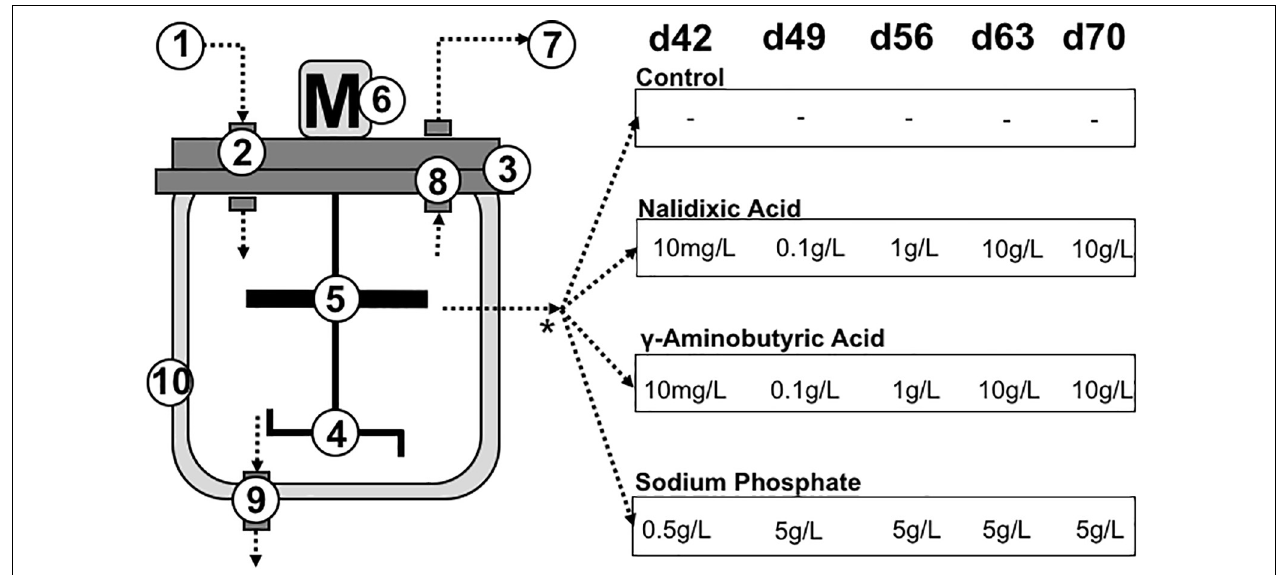
FIGURE 1 | Reactor set-up: To compare the influence of different inhibitors on microbial interactions, four experiments were performed in continuous stirred tank reactors. The left side of the figure shows the reactor design: (1) Substrate input, (2) gas tight feeding pipe, (3) lid, (4) stirrer, (5) upper stirrer for foam elimination, (6) motor for the stirrer, (7) gas output, (8) gas tight pipe, (9) sampling port, (10) double wall for heating. The experiment lasted 77 days, with chemical inhibitors applied on day 42, 49, 56, 63, and 70. Nalidixic acid, γ -aminobutyric acid (GABA) and sodium phosphate were applied as chemical inhibitors. One reactor received no additional inhibiting chemicals to function as a